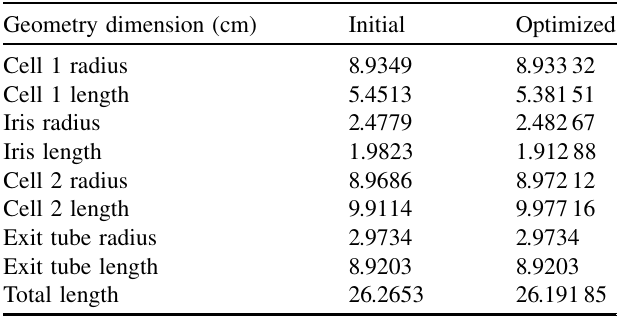
TABLE IV. Optimization initial and optimized straight line